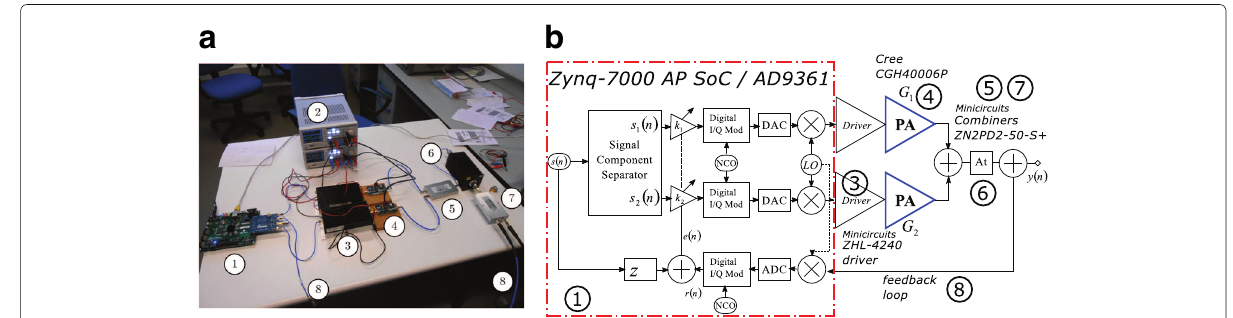
Fig. 7 Experimental setup. a Hardware implementation. b Equivalent black-box diagram corresponding to experimental test